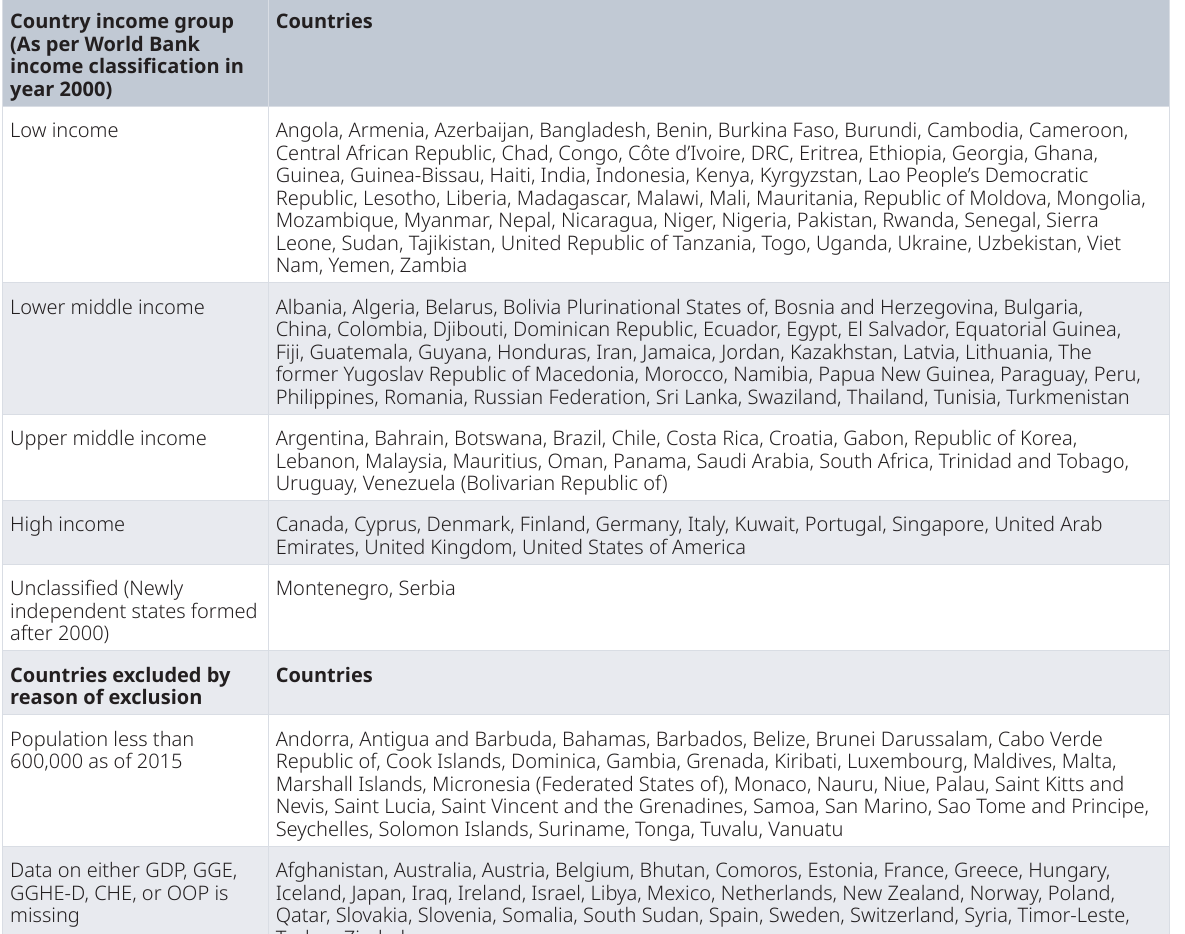
Table 1. List of countries included in analysis and list of countries excluded (and why). Country income group (As per World